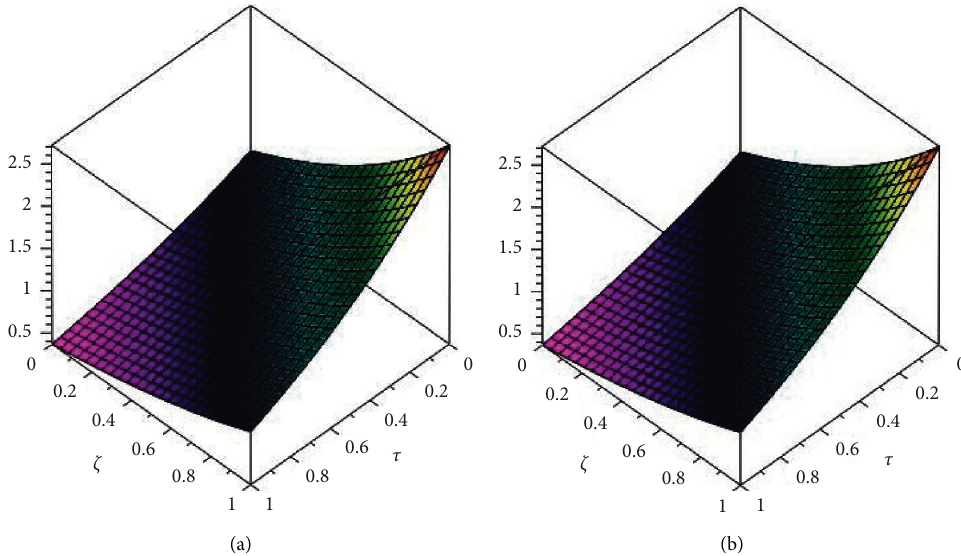
Figure 3: Graph of (a) exact and (b) analytic solutions of β � 1 of Example